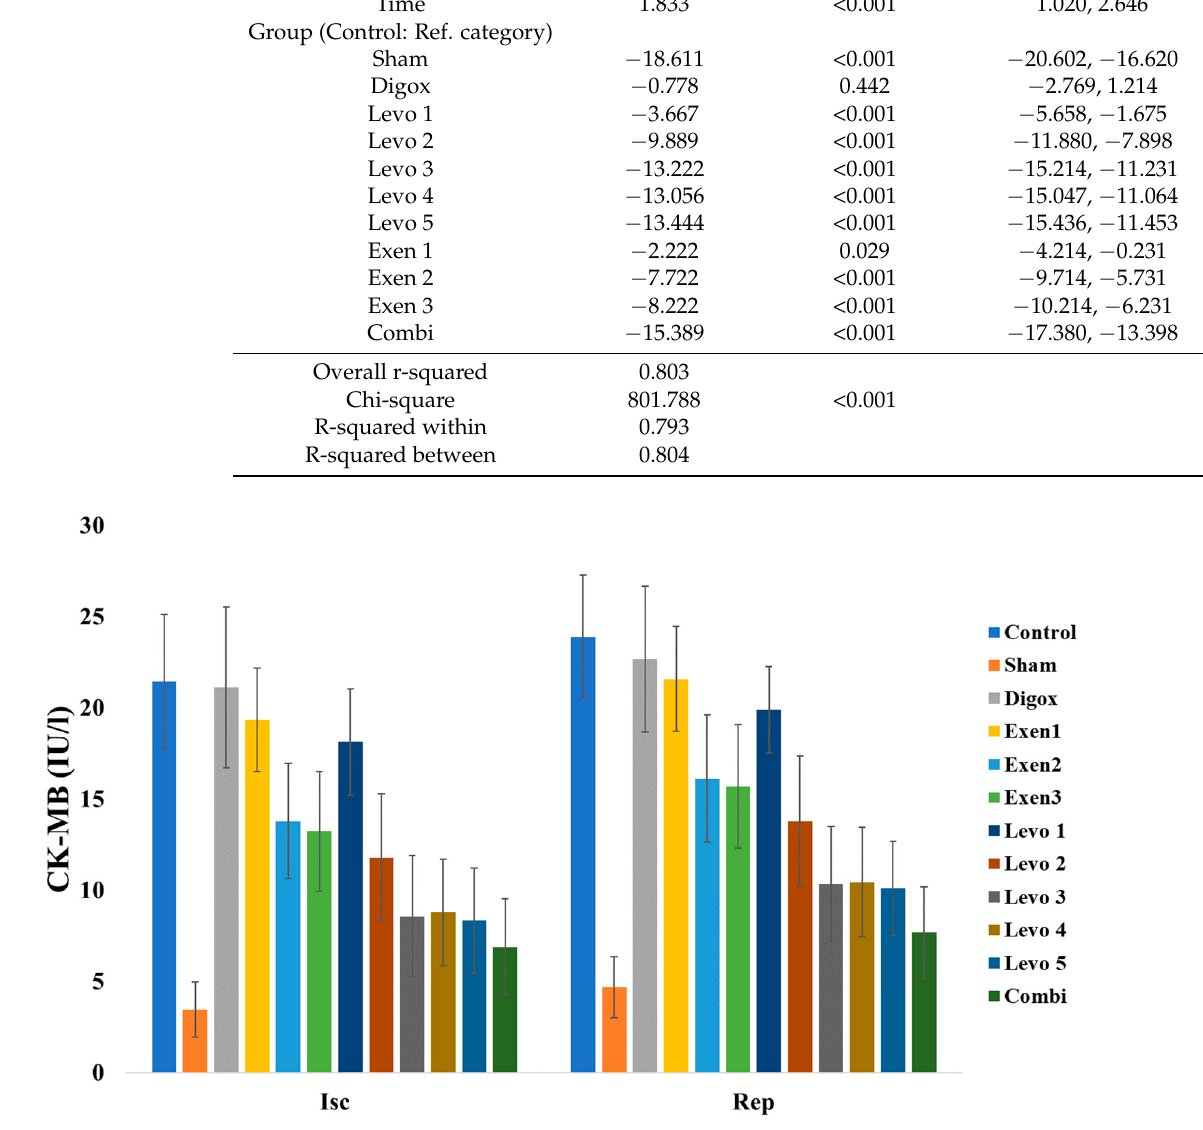
Figure 13. Changes in CK-MB across groups over time.